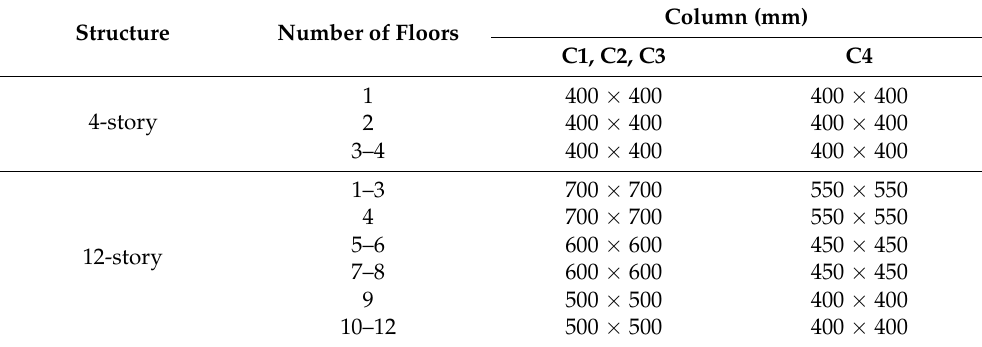
Table 7. Column and brace